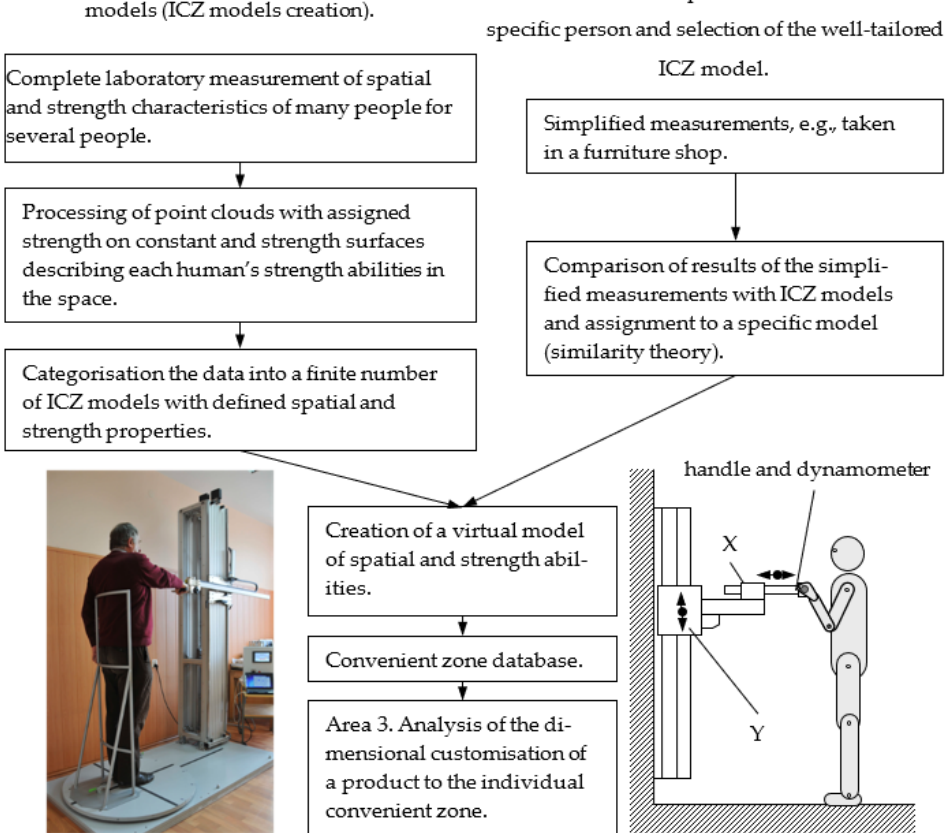
Figure 2. Algorithm of procedure for measuring convenience.